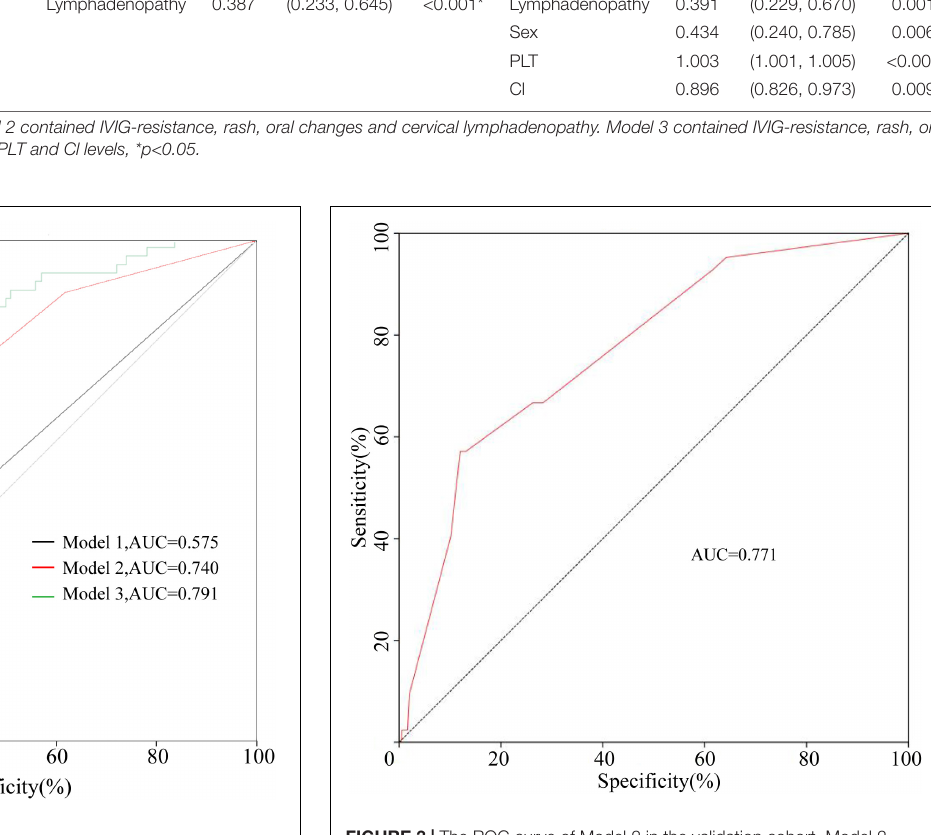
FIGURE 2 | The ROC curves of the three models in the development cohort. Model 1 contained IVIG resistance. Model 2 contained IVIG resistance, rash, oral changes, and cervical lymphadenopathy. Model 3 contained IVIG resistance, rash, oral changes, cervical lymphadenopathy, sex, PLT, and Cl levels.